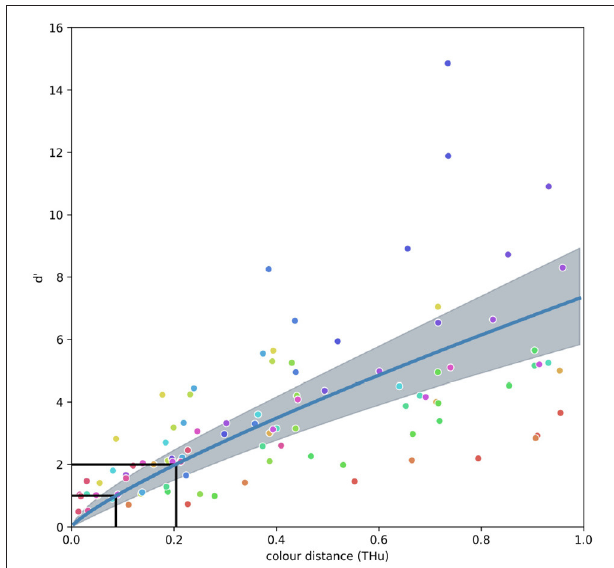
FIGURE 4 | Fixed terms model representing the colour discrimination sensitivity function (CDSF) and associated 95 % credibility intervals for a violet-sensitive bird observer predicting the sensitivity index ( d ′ ) for a discrimination task between stimuli of increasing colour dissimilarity ( 1 C ). Sensitivity index is related to the ratio of hits to false positives with d ′ 1 ≥ representing a proportion of hits above 75% with ratio of false positives < 30% as illustrated by the ROC curve in Figure 1 . Colour circles represent the 20 different reference wavelengths tested by Wright (1972), colour code is the same as in Figure 5 . Black lines indicate the 1 C values of 0.088 and 0.204 THu required to attain d ′ 1 and d ′ 2, respectively. = =